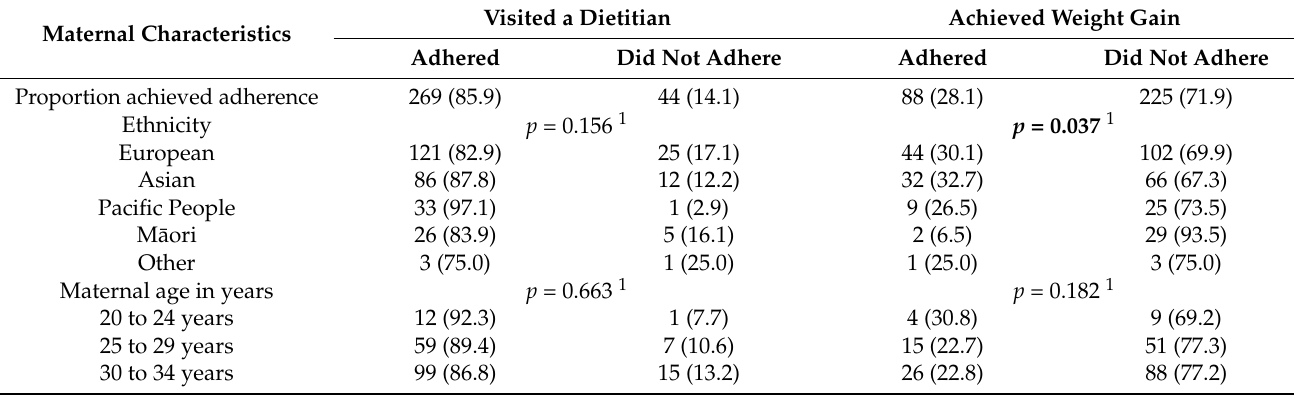
Table 6. Maternal characteristics and demographics associated with visitation to the dietitian and recommended weight